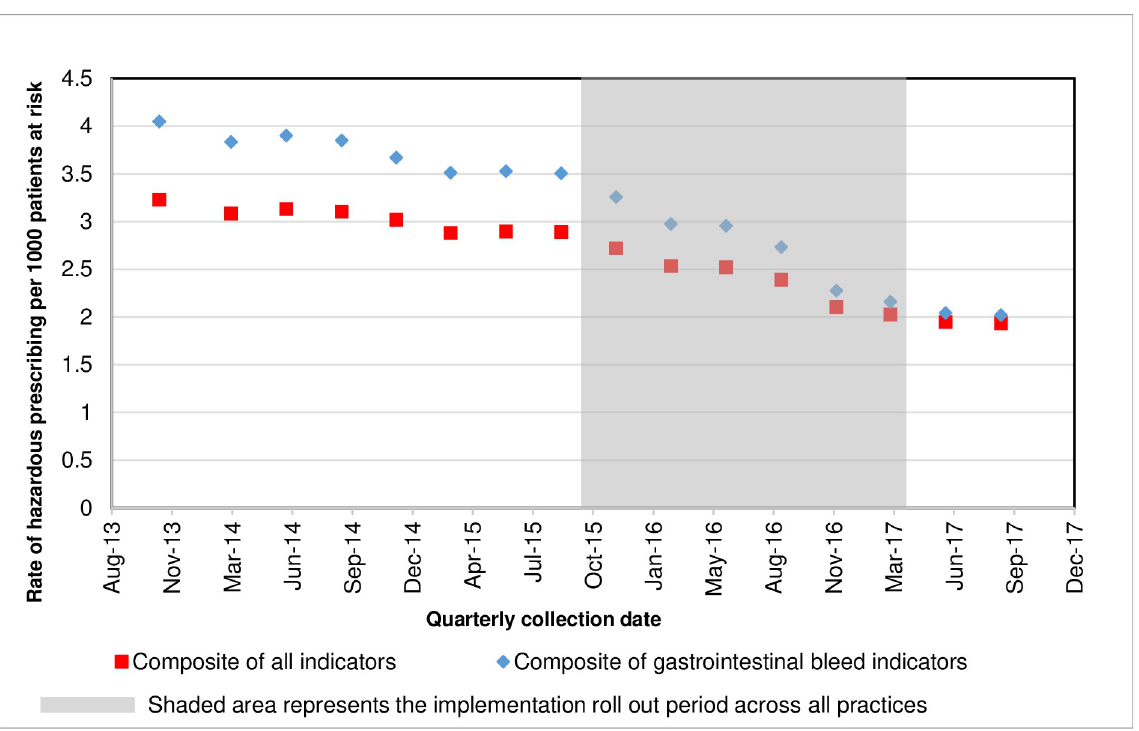
Fig 1. Hazardous prescribing rate by calendar quarter for the composite prescribing indicators using data from all practices combined.